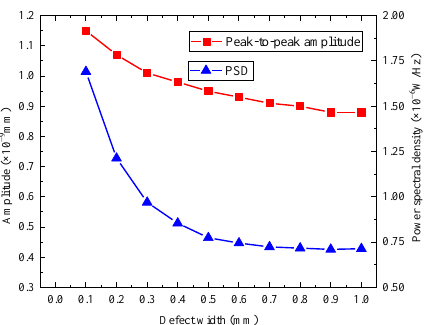
0.0 0.1 0.2 0.3 0.4 0.5 0.6 0.7 0.8 0.9 Figure 32. The influence of defect width on the received signal (transmitted Figure 32. The influence of defect width on the received signal (transmitted wave).